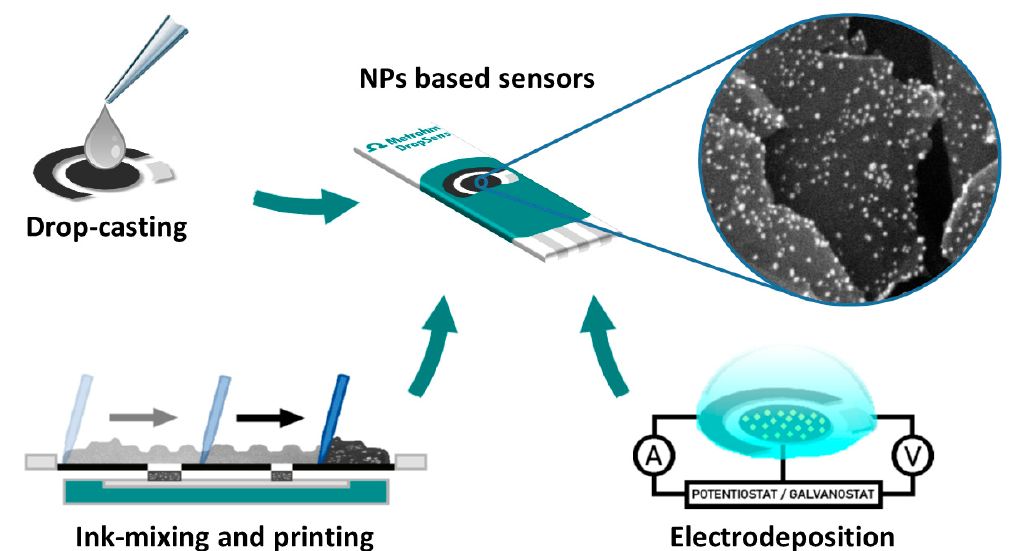
Figure 1. Schematic representation of the three main methodologies usually employed to modify SPEs with metal NPs.